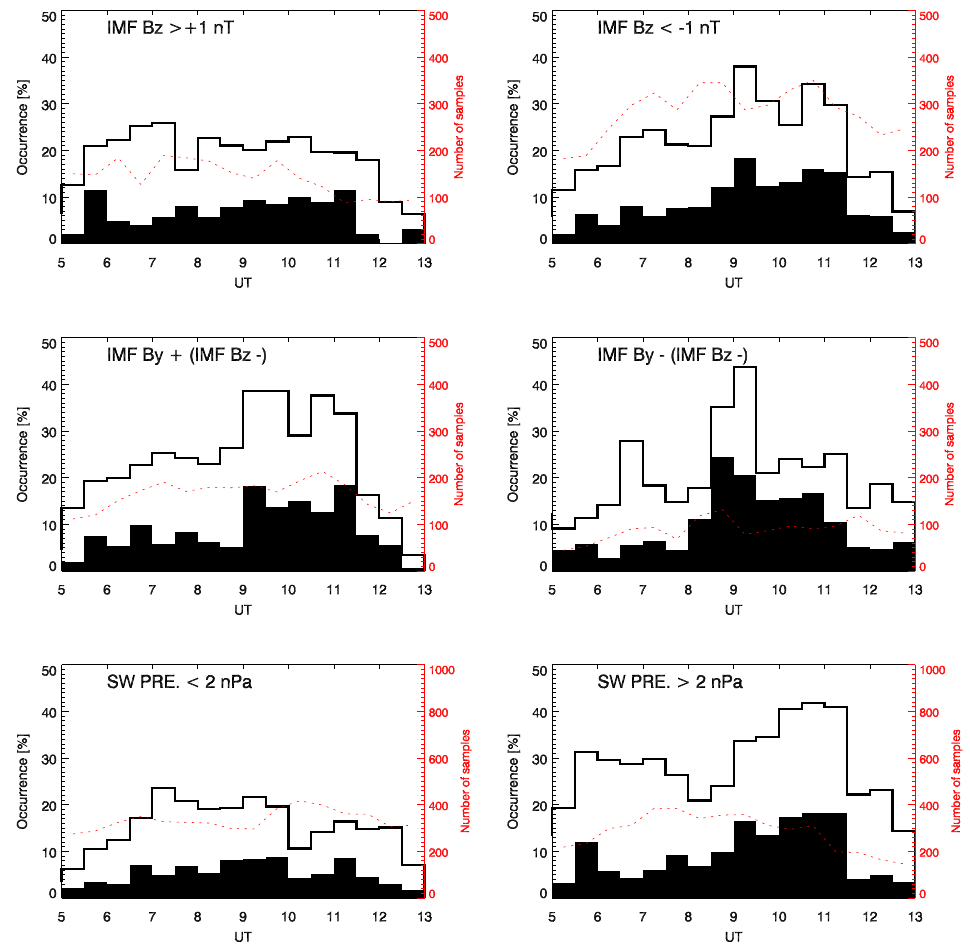
Fig. 9. Histograms of occurrence frequency of up- and downflow over UT for different directions of the interplanetary magnetic field and for different solar wind pressures. The outlined histogram indicates the occurrence frequency of upflow events and the histogram filled with black indicates how often simultaneously downflow occurred. Also, the number of available velocity profiles is displayed (red